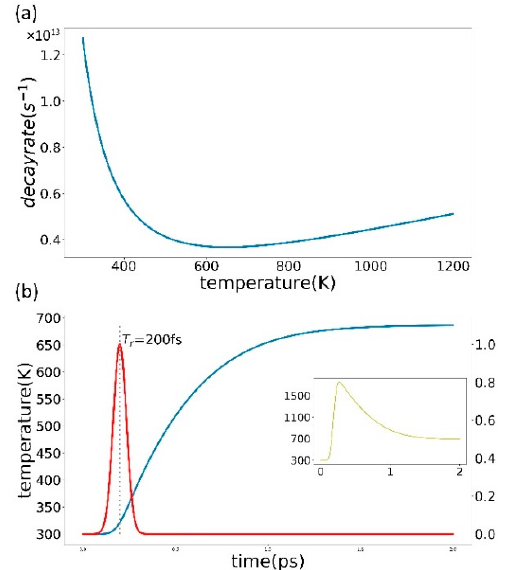
Figure 2. ( a ) The intersystem crossing (ISC) rate fluctuates with temperature; ( b ) The lattice temperature fluctuation over time; the electron temperature over time is in the box at right.